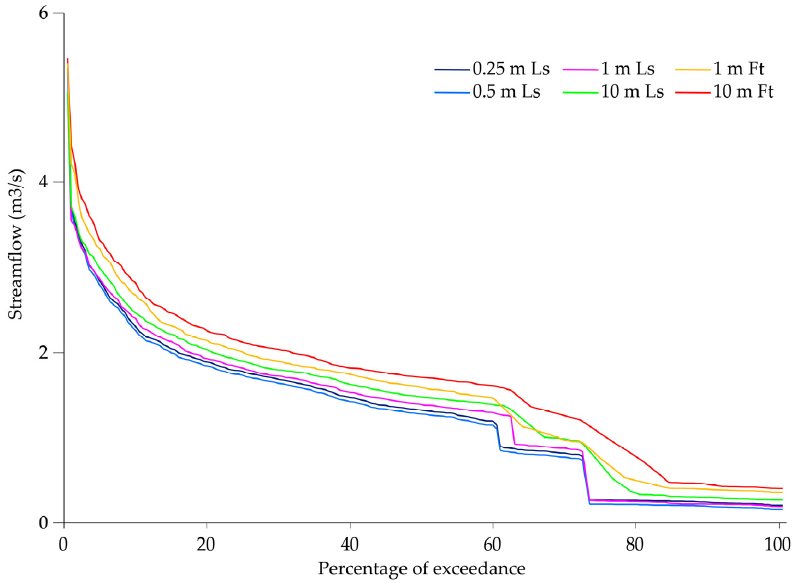
Figure 8. Normalized flow-duration curves for the terraces (Ls DEMs) and no terraces (10 m and 1 m Ft DEM and 10 m Ls DEM) scenarios. Ft DEM and 10 m Ls DEM)